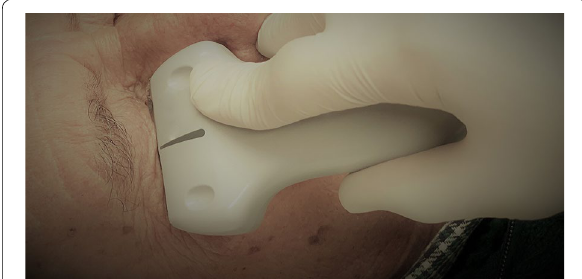
Fig. 1 Ultrasonographic pupillary assessment. The 7.5–15 MHz linear transducer gently placed over the lower edge of the closed eye for a trans-palpebral tangential view